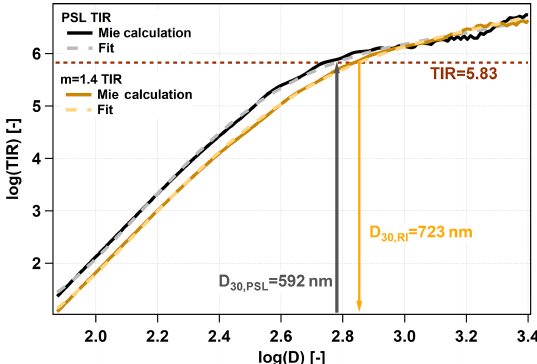
Figure 2. LAS theoretical instrument responses for m = 1 . 588 + 0 i (black) and 1 . 40 + 0 i (orange) as a function of the particle diameter. Here we show an example of how an original LAS diameter bin border ( D 30 , PSL ) was recalculated to the target RI ( D 30 , RI